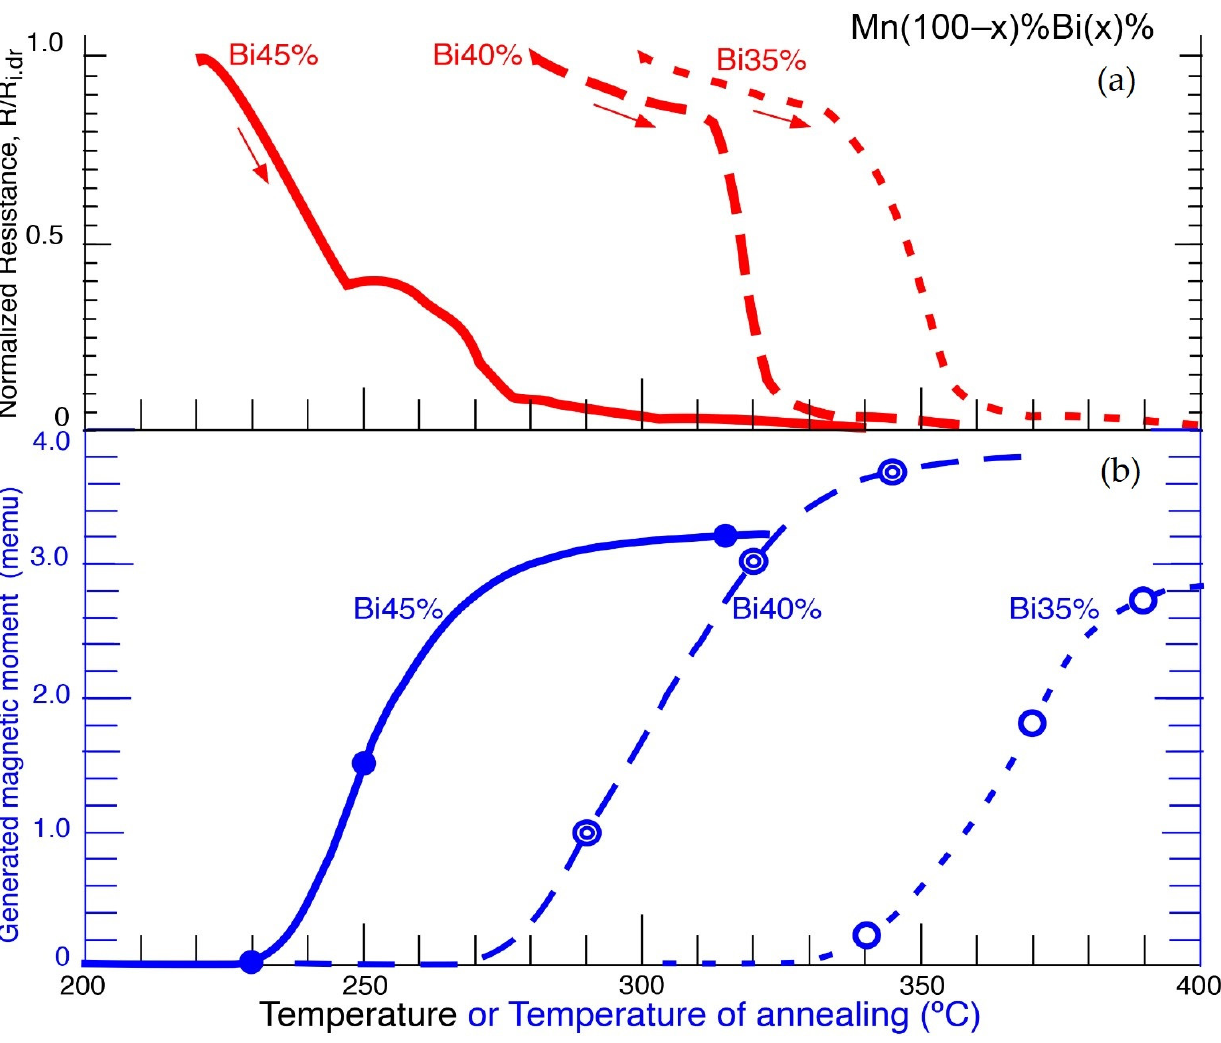
Figure 6. Normalized resistance change as a function of the temperature for the different samples ( a ). The arrows indicated that the resistance was measured on increasing the temperature. Gener- ated magnetic moment as a function of the annealing temperature for the different MnBi samples. Continuous and dashed lines are visual guides in ( b ).